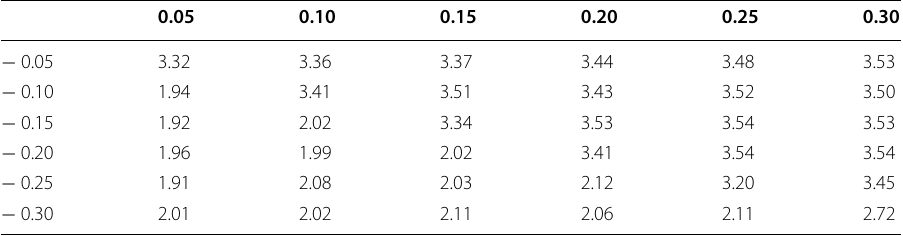
The first row shows the φ values, whereas the first column shows the φ + Table 5 Average returns for different price limit combinations